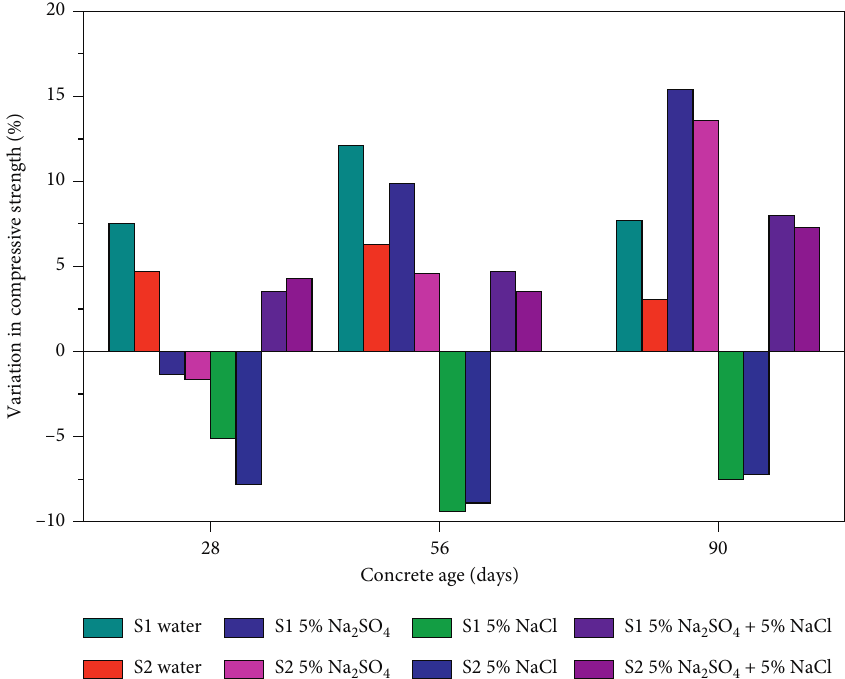
Figure 4: Compressive strength variation of CT, S1, and S2 immersed in water, sulphate, and chloride at different concrete ages.